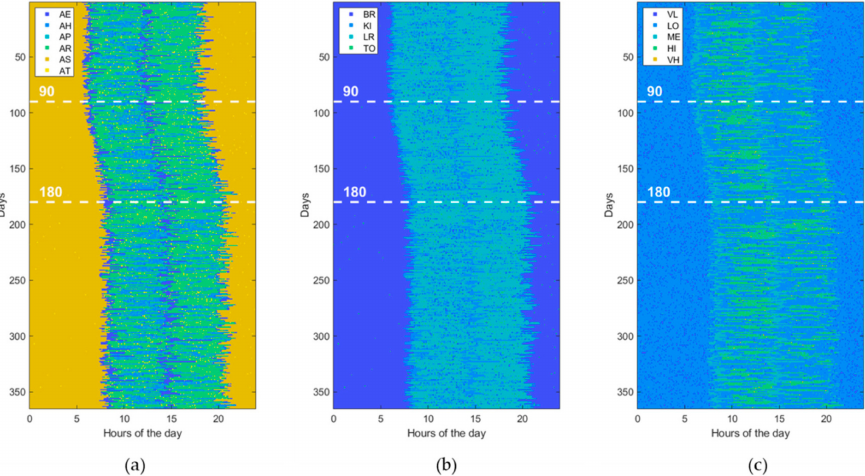
Figure 6. Example of an abnormal data set, due to a change in the “Starting time of activity” (St). The change gradually takes place from the 90th day on. ( a ) ADL, ( b ) LOCs, and ( c ) HRLs.